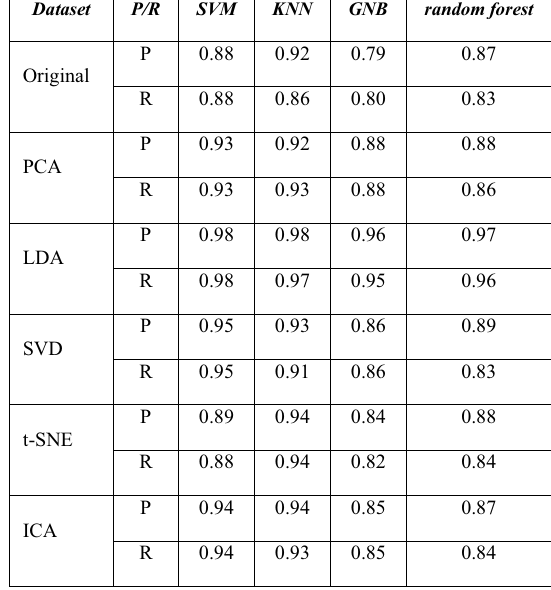
Table 6. Precision and recall of original and